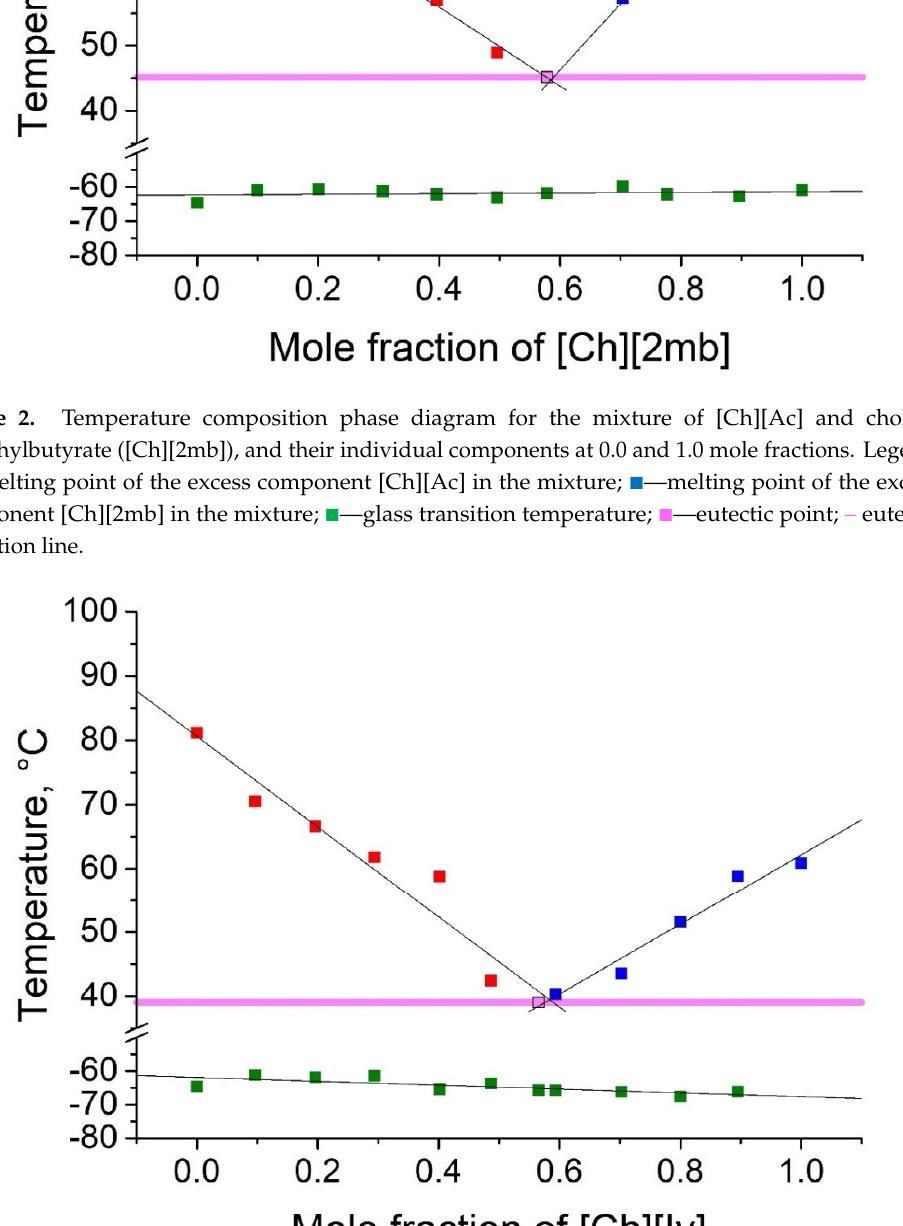
Figure 3. Temperature composition phase diagram for the mixture of [Ch][Ac] and choline isovalerate ([Ch][Iv]), and their individual components at 0.0 and 1.0 mole fractions. Legend: ▪—melting point of the excess component [Ch][Ac] in the mixture; ▪—melting point of the excess component [Ch][Iv] in the mixture; ▪—glass transition temperature; ▪—eutectic point; – eutectic transition line.